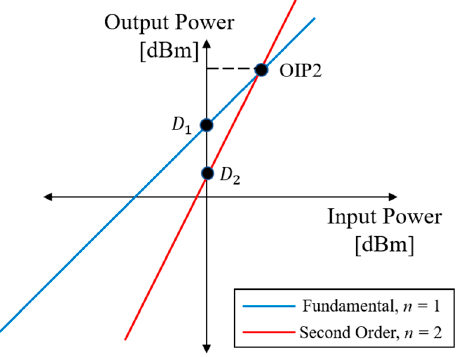
Figure 2. Illustration of the relationship between OIP 2 and D 2